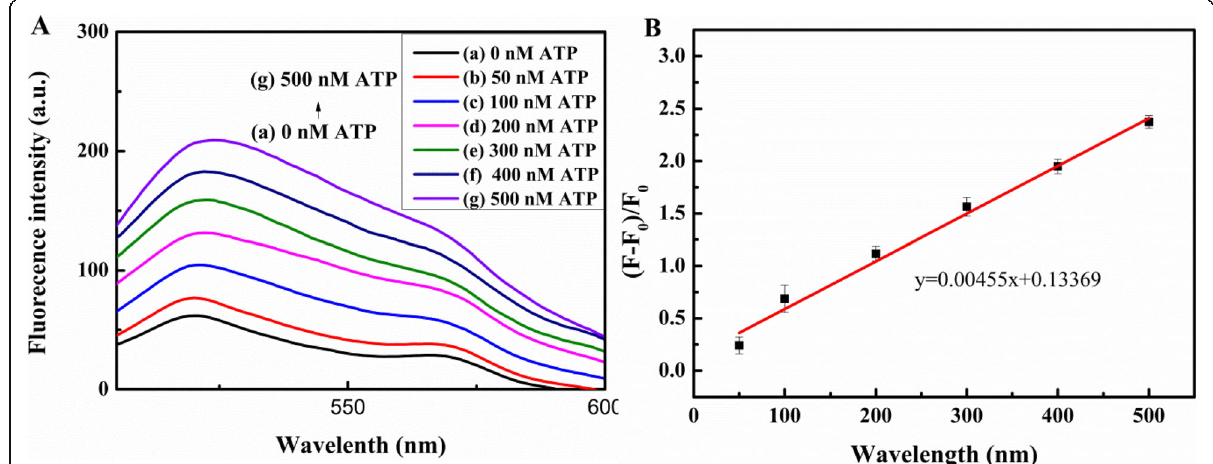
Fig. 5 a Spectral curves of the various ATP concentrations. b Linear